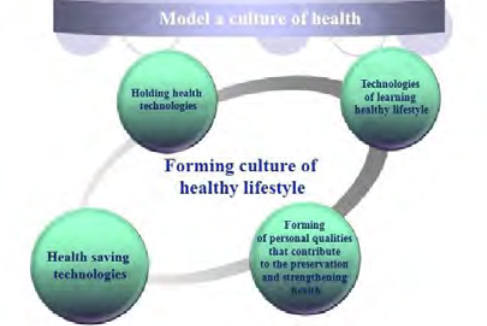
Fig.1. Model of formation of schoolchild’s health culture